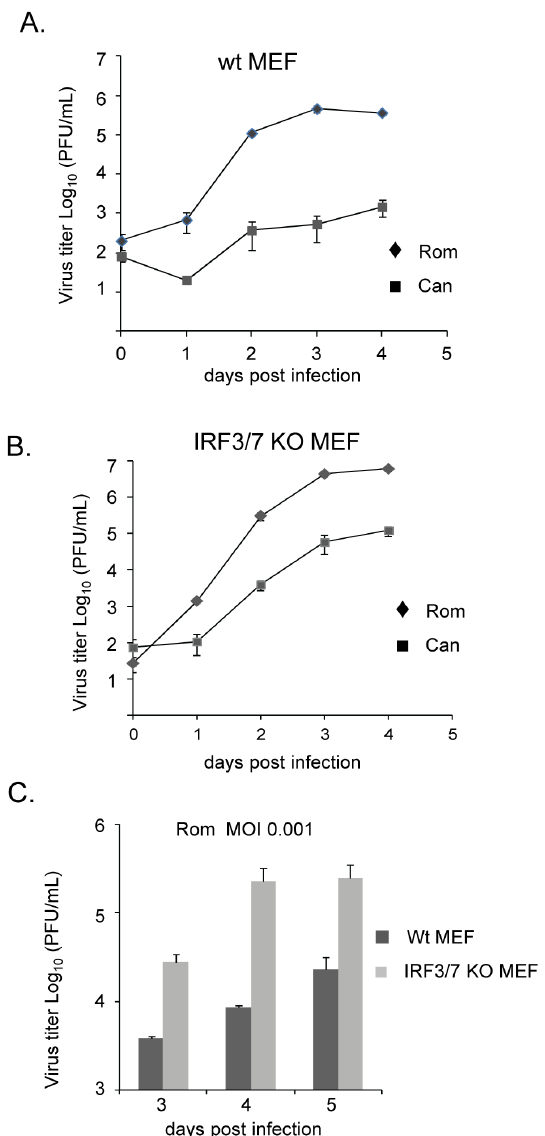
Figure 2. Growth kinetics of JUNV in wild-type MEF and IRF3/7 knockout MEF. Wild-type MEF cells (A) and IRF3/7 knockout MEF cells (B) were infected by Romero (Rom) and Candid # 1 (Can) viruses at an MOI of 0.1. (C) Wild-type MEF cells and IRF3/7 knockout MEF cells were infected by Romero virus at an MOI of 0.001. Supernatants from infected cells were harvested daily and subjected to plaque assay. Note: the titer of Candid # 1 virus was below the detection level in both MEFs at an MOI of 0.001. Data represent the mean of triplicates 6 SEM. Wt MEF: Wild-type MEF cells. IRF3/7 KO MEF: IRF3/7 knockout MEF cells.